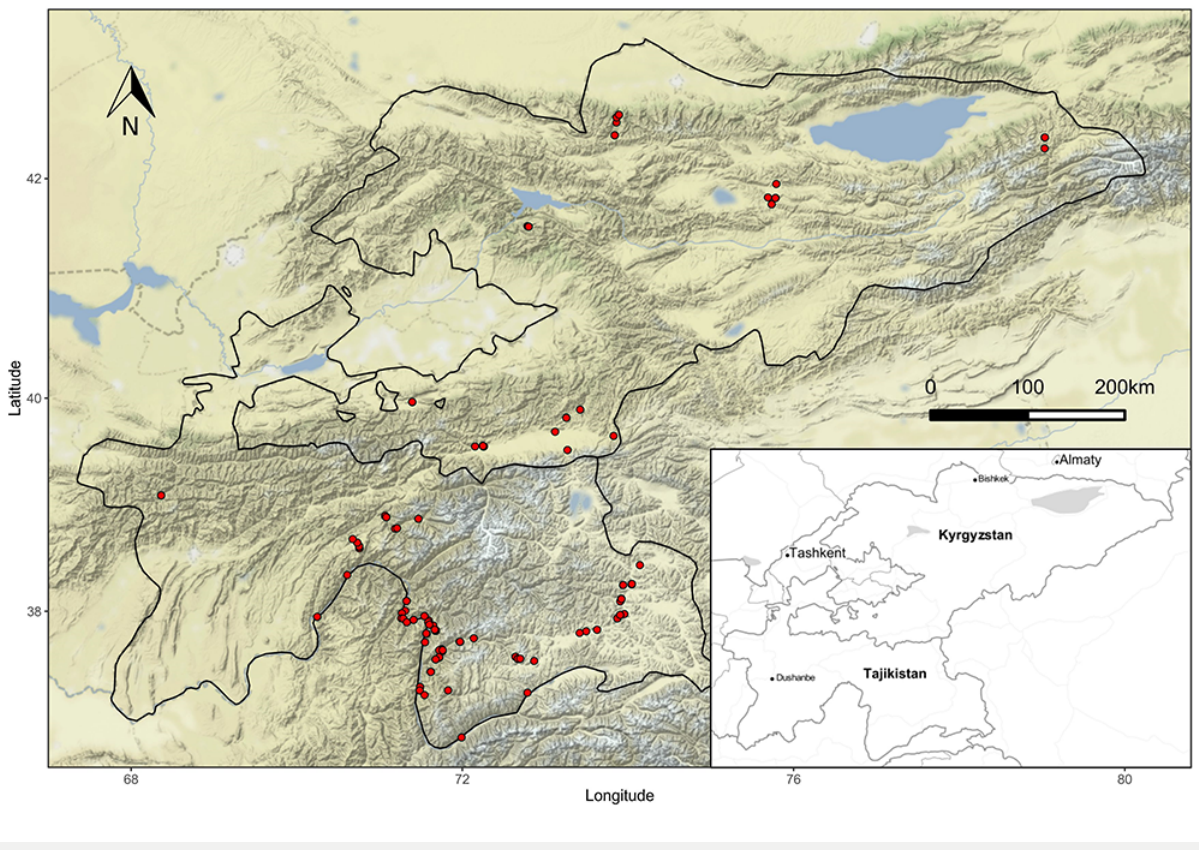
Figure 1 Study area and spatial distribution of